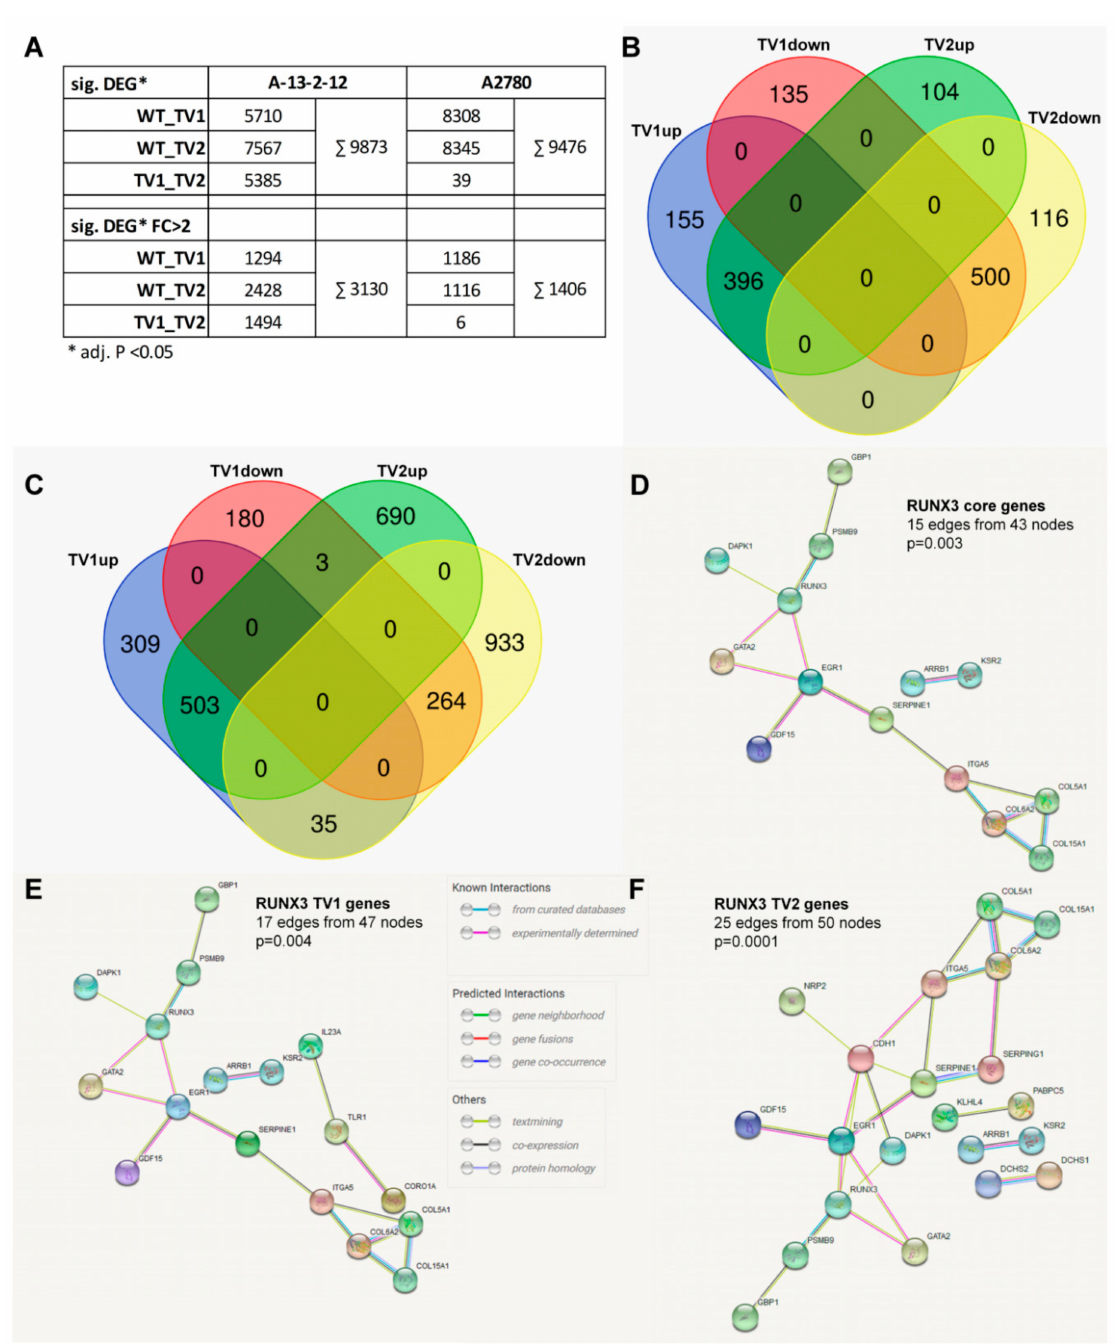
Figure 4. Genome-wide gene expression analysis after RUNX3 TV1 or TV2 overexpression. ( A ) Overview of the absolute numbers of significant differentially expressed genes (DEGs) (adjusted p < 0.05) and the significant DEGs exhibiting a log2FC > 1. ( B , C ) Venn-diagram of up- and downregulated DEGs with log2FC > 1 from A2780 ( B ) and A13-2-12 cells ( C ) after RUNX3 TV overexpression. ( D – F ) String protein interaction networks from genes identically regulated by RUNX3 transcript variants and detected as deregulated in both cell-lines (RUNX3 core genes; ( D ) or from these genes combined with genes specifically regulated by TV1 ( E ) or TV2 ( F